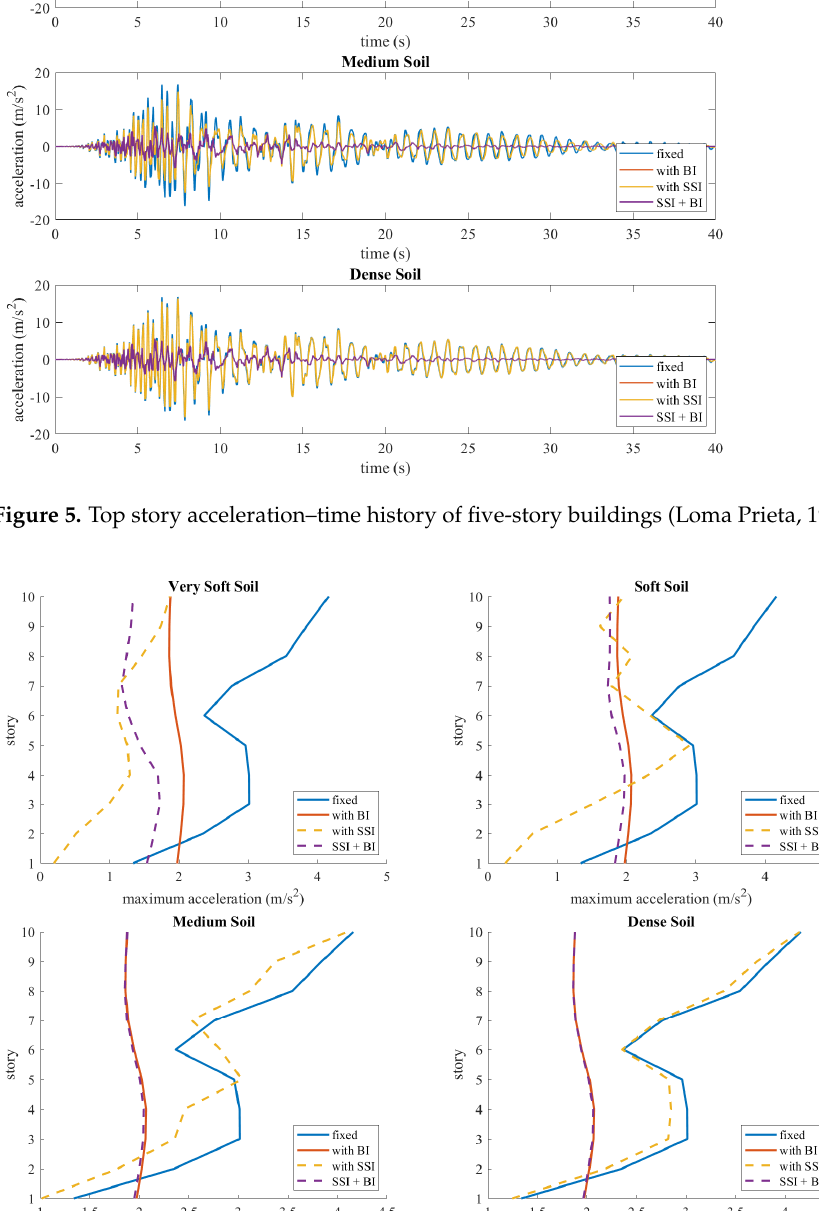
Figure 7. Top story displacement–time history of the ten ‐ story building (Kocaeli, 1999).